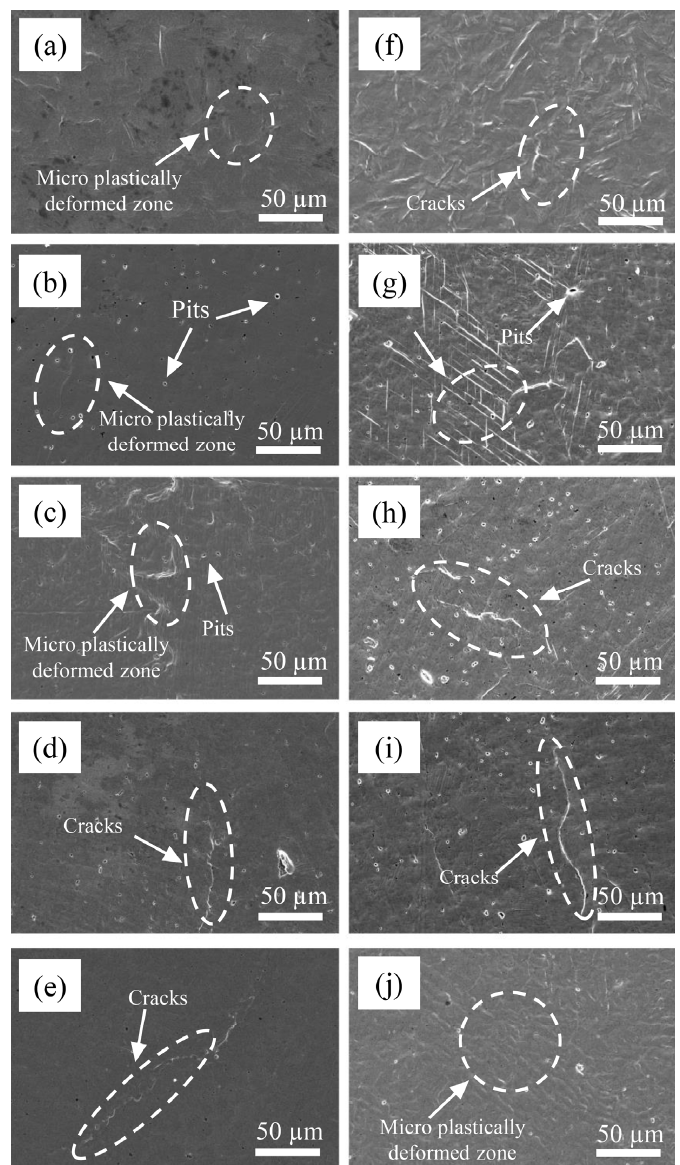
Figure 11. The surface morphologies of Cr20 ( b , g ), Cr25 ( c , h ), Cr20 ( d , i ), Cr20 ( e , j ), and 0Cr13Ni5Mo steel ( a , f ) after CE tests for ( a – e ) 0.5 h and ( f – j ) 1 h in distilled water.